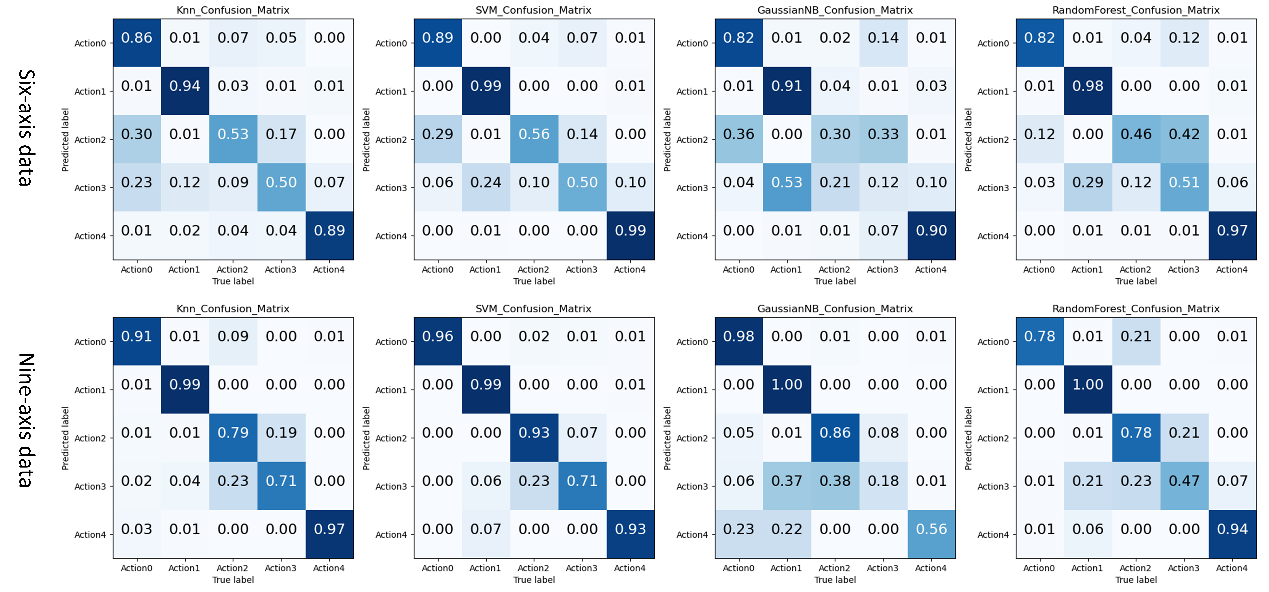
Figure 11. The traditional machine learning model based on artificial features recognizes the result confusion matrix on the professional test set.